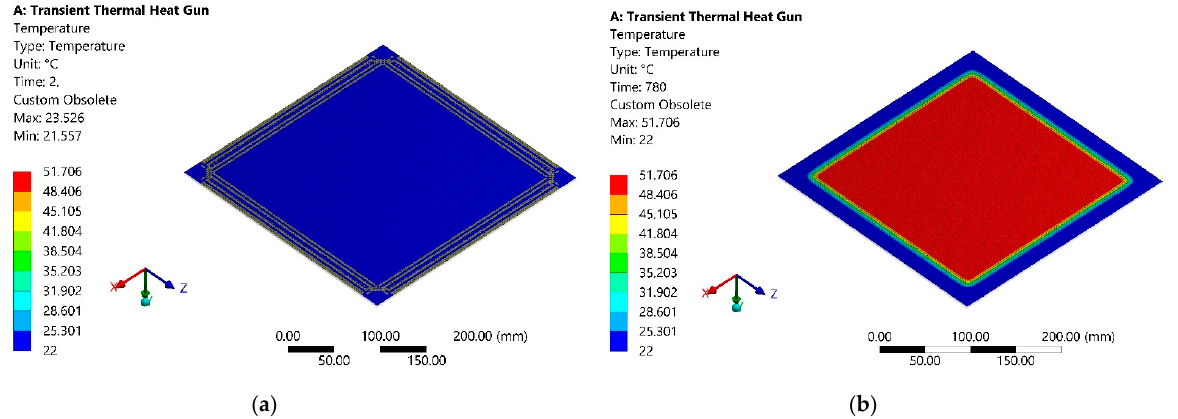
Figure 2. Temperature distribution on the opposite to the heating surface: ( a ) after 2 s from heating beginning; ( b ) after 780 s from the start of heating.